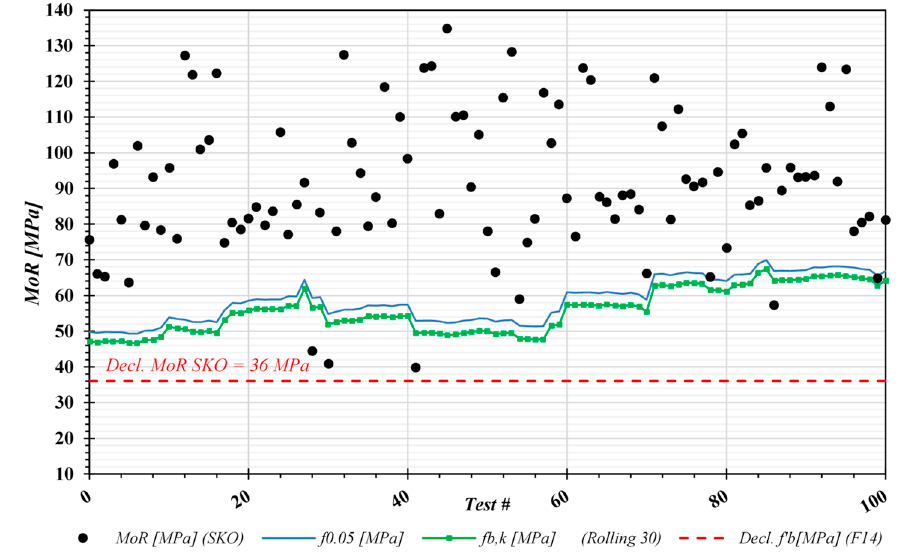
Figure 4. Bending strength of solid timber specimens over 100 tests.